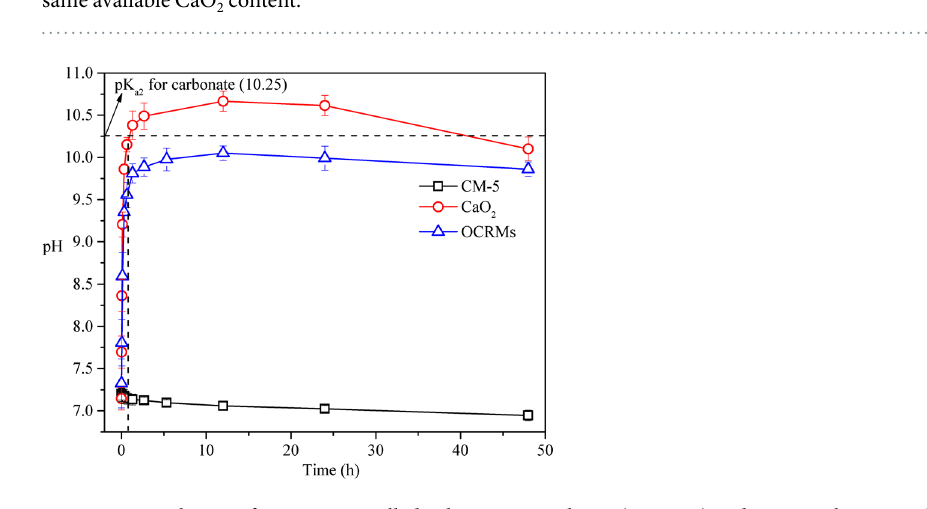
Figure 5. pH change of oxygen controlled-release microspheres (OCRMs) and CaO 2 with time in the experiment. The initial pH is around 7.2 (with 0.3 mg/L phosphate). Both OCRMs and CaO 2 have the same available CaO 2